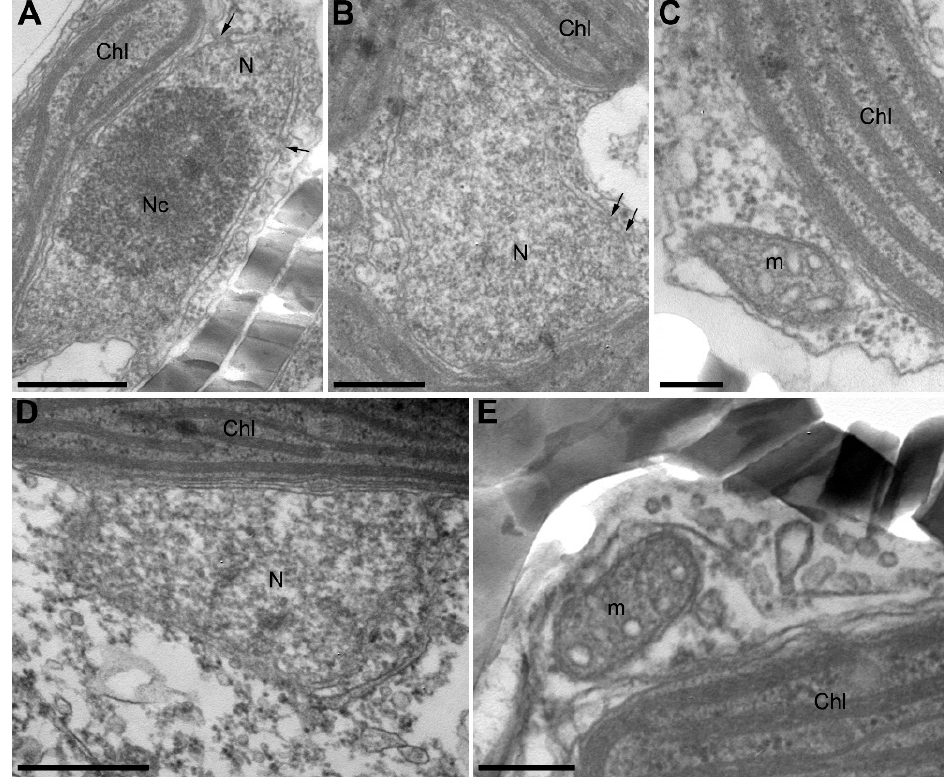
Figure 6. U. acus cells in axenic culture ( A – C ) and after culturing with B. mycoides BS2-15